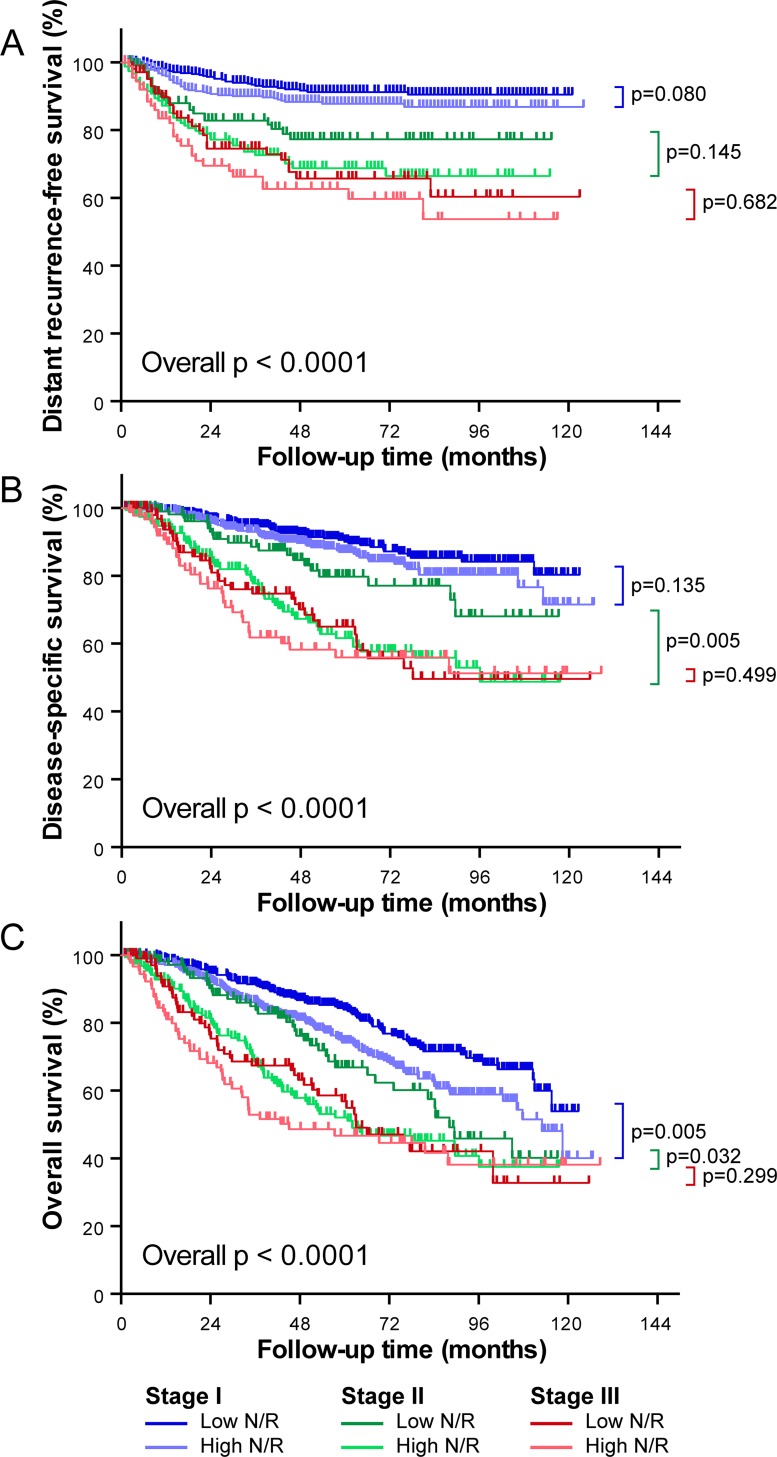
Kaplan-Meier survival curves for NSCLC patients in relation to pathologic stage and NLR.P values were determined by the log-rank test. (A) Distant recurrence-free survival, (B) disease-specific survival, and (C) overall survival. Patients with high NLR had shorter OS compared to those with low NLR with stage I disease (P = 0.005). Patients with high NLR had both DSS and OS shorter than those in patients with low NLR in stage II disease (P = 0.005 and 0.032, respectively).